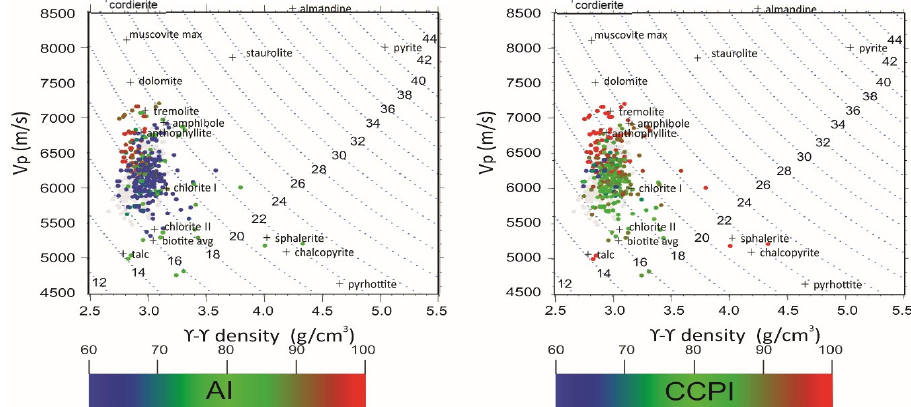
Figure 4. P-wave velocity ( V p) and density of rocks with mafic-intermediate volcanic protoliths from the footwall of the Lalor VMS deposit. Points are colored according to the Ishikawa (AI) and chlorite-carbonate-pyrite-index (CCPI) alteration indices. The isolines indicate acoustic impedance (Z) in kg/m −2 s −1 × 10 −6 .